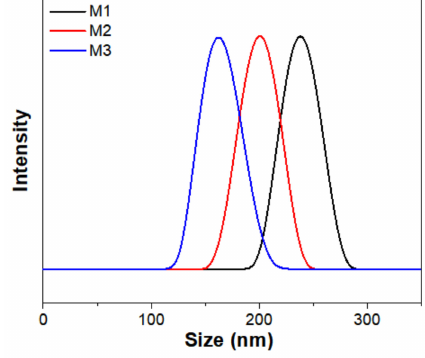
Figure 3. Dynamic light scattering (DLS) results of micelles M1 – M3 with PtTFPP. Table 2. Properties of micelles M1 – M3 . DLS: dynamic light